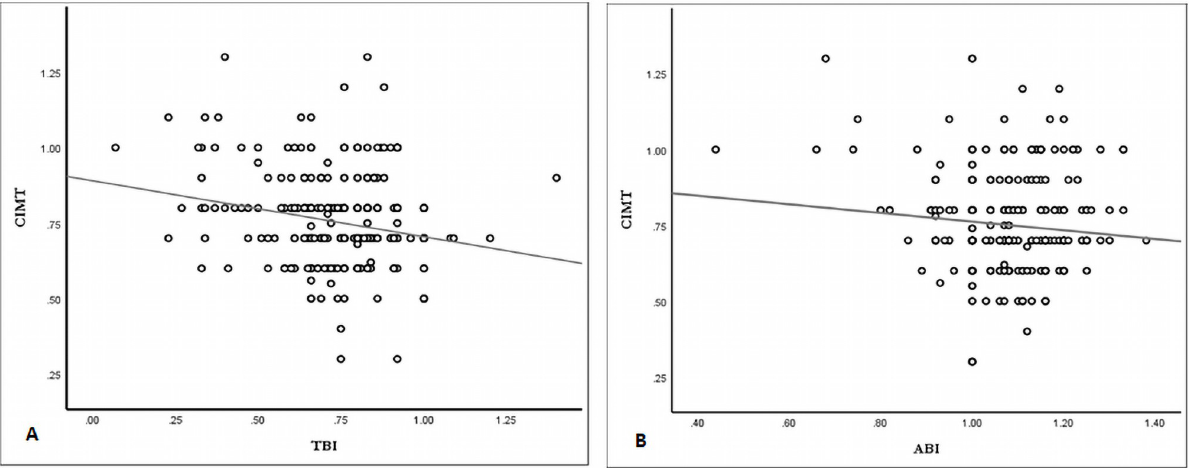
Fig 1. Graph illustrating correlation between right CIMT and TBI (A) and ABI (B). CIMT: carotid intima media thickness. TBI: toe brachial index. ABI: ankle brachial index.